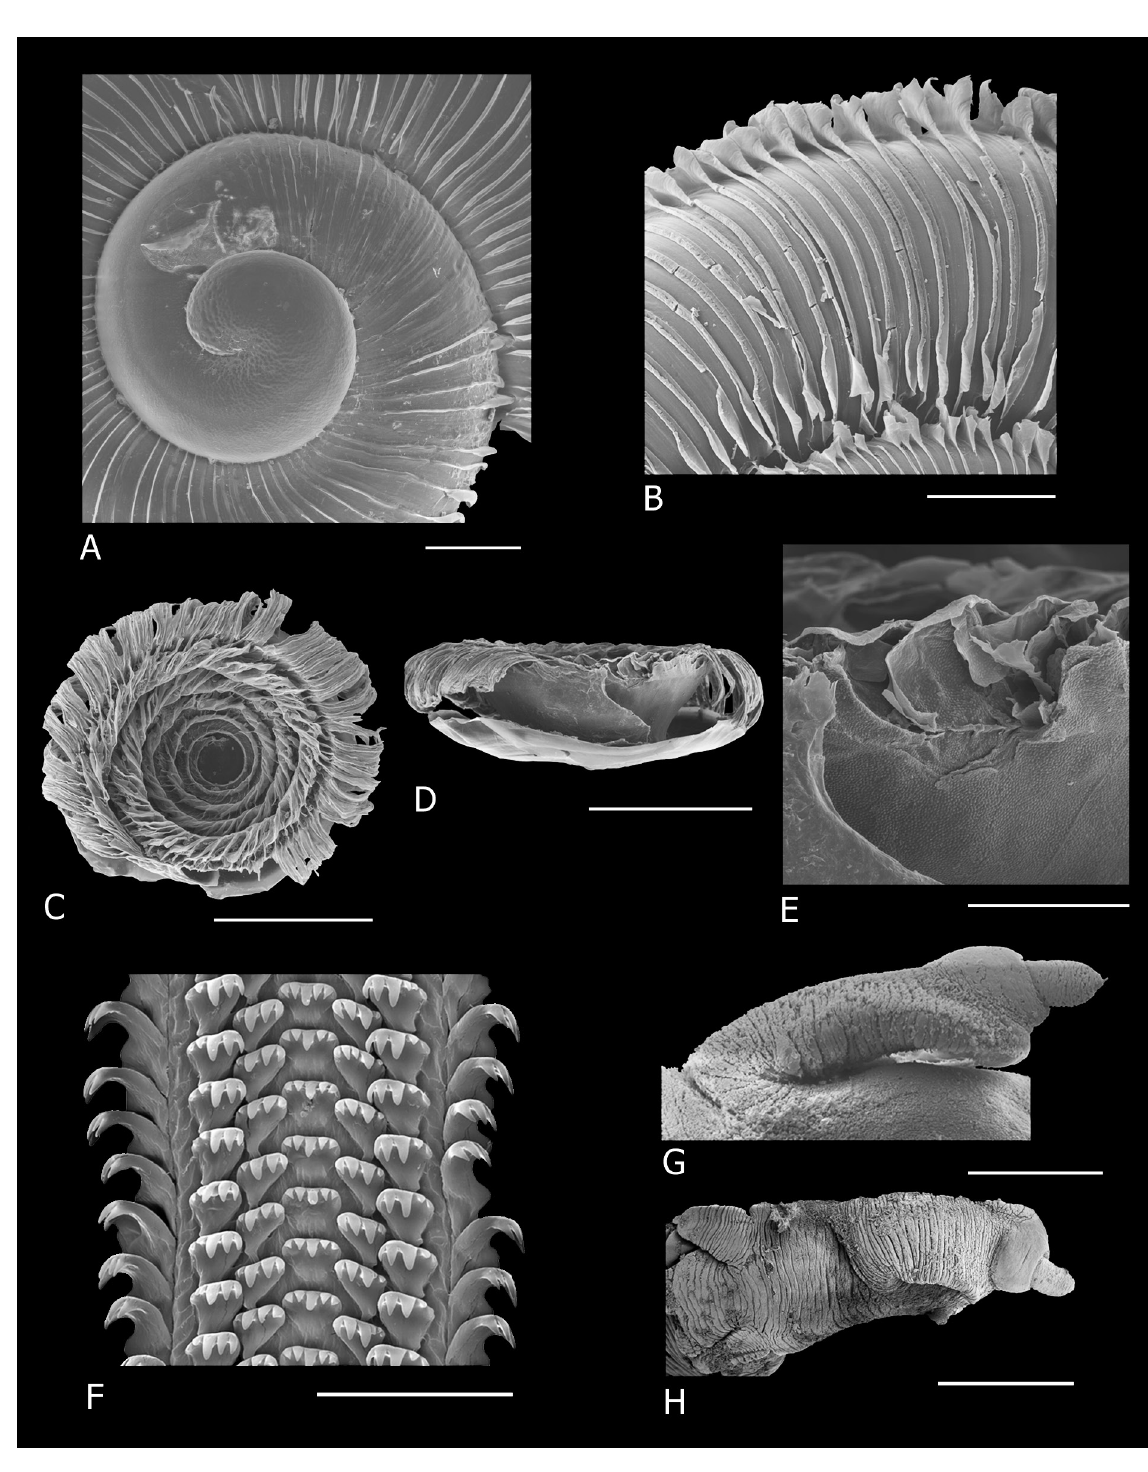
Fig. 21. Chondrocyclus bathrolophodes Connolly, 1929. A . Protoconch (ELM D15882). B . Detail of axial lamellae of periostracum (ELM W3616). C–D . Operculum (ELM W3616). E . Detail of sculpture of wall of operculum (ELM W3616). F . Portion of radula (ELM W3616). G . Penis, lateral view (ELM W3658). H . Penis, dorsal view (ELM W3616). Scale bars: A, E = 200 µm; B, G–H = 500 µm; C–D = 1 mm; F = 50